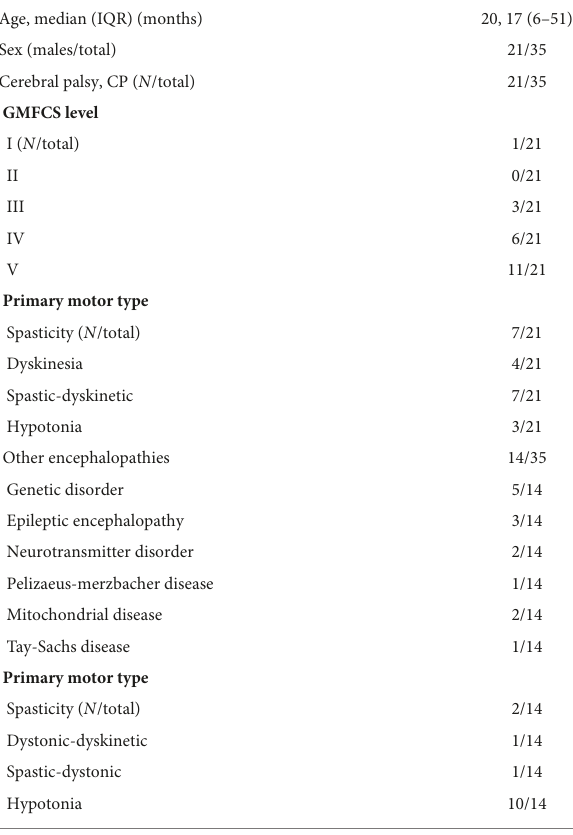
TABLE 1 Demographics and clinical characteristics.